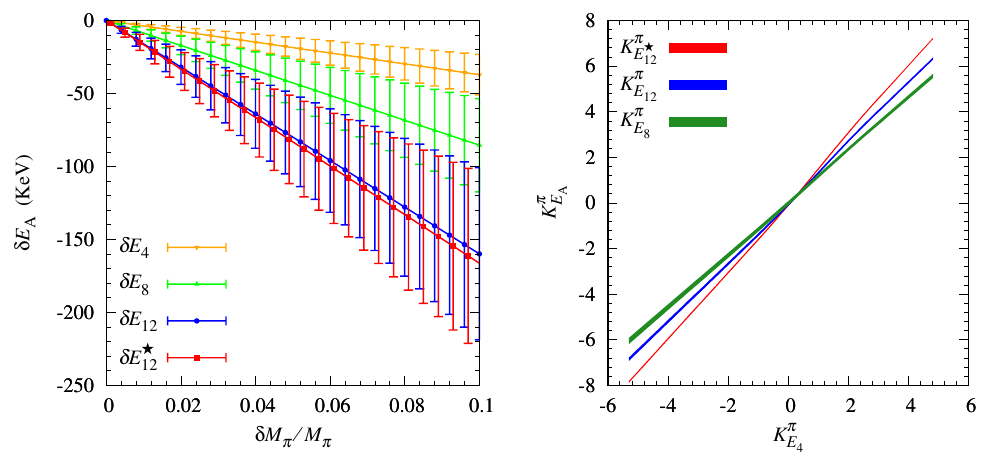
Figure 2 . Left panel: variation of the ground state energy of the nuclei 4 He, 4 Be, 12 C and the Hoyle state 12 C ? , respectively, under variation of the pion mass (in percent). Right panel: sensitivity of the ground state energy of the nuclei 8 Be, 12 C and the Hoyle state 12 C ? , respectively, to changes in M as a function of K π under independent variations of ¯ A π E 4